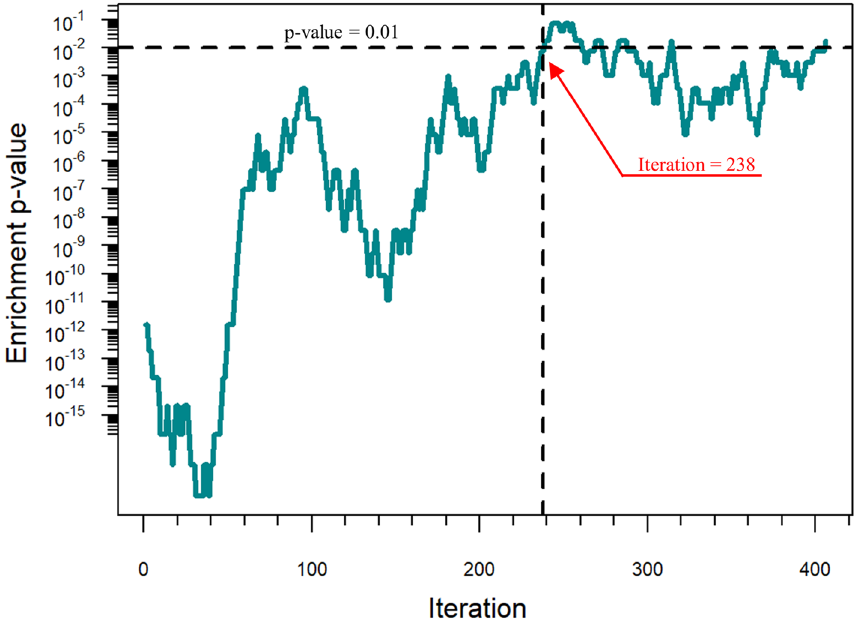
Figure 3. Biological evaluation of DIAMOnD predictions. The significance (enrichment p value ≤ 0.01) of the similarity between DIAMOnD predicted disease genes and seed genes suggests a cutoff corresponding to the iteration